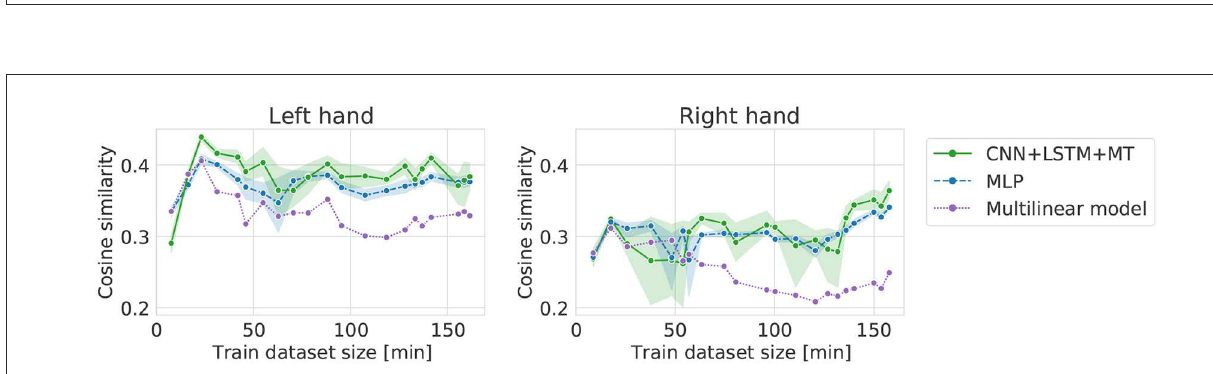
FIGURE7 Cosine similarity for backward increase experiment, i.e., different training dataset sizes when starting from the 21st session and going backward (left, right)